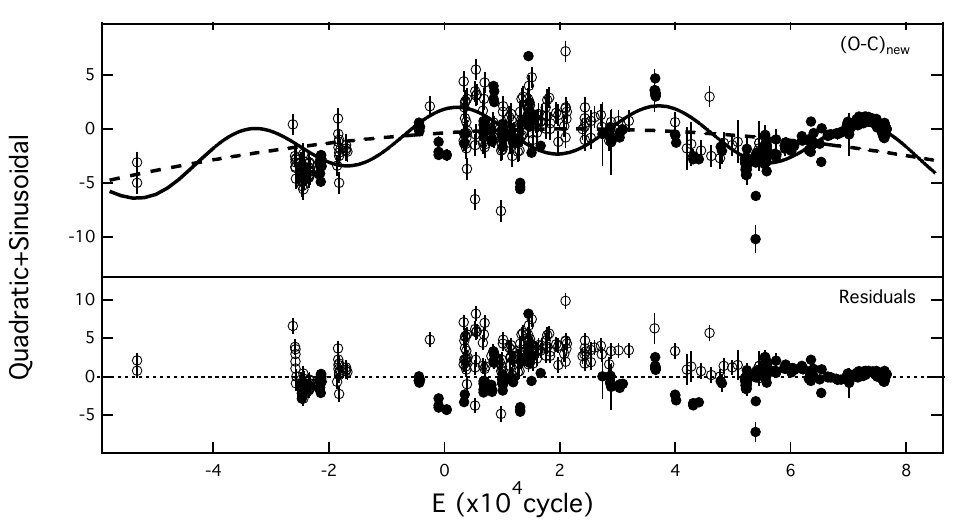
Figure 2. The quadratic-plus-sinusoidal fitting curves denoted by the solid lines, including their corresponding fitting residuals, are shown from top to bottom. The dash lines refer to the quadratic fitting curve. The symbols of the data points and the y-axes are the same as those used in Figure